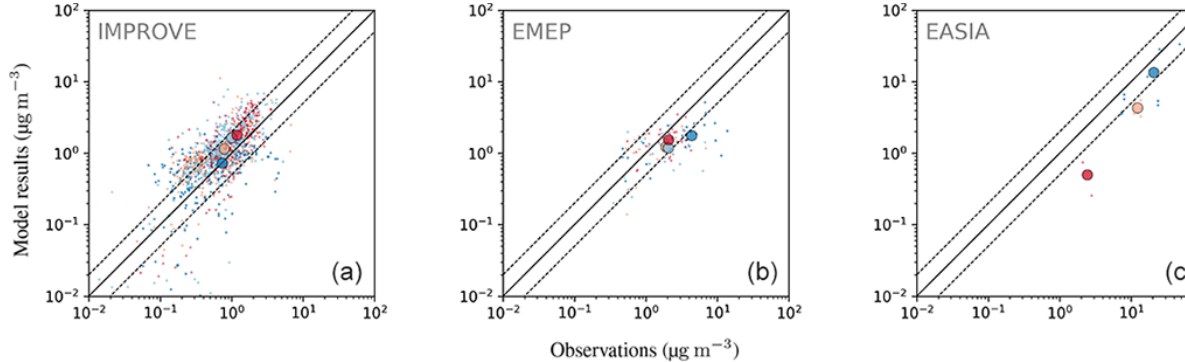
Figure 29. The same as Fig. 20 but for OA.